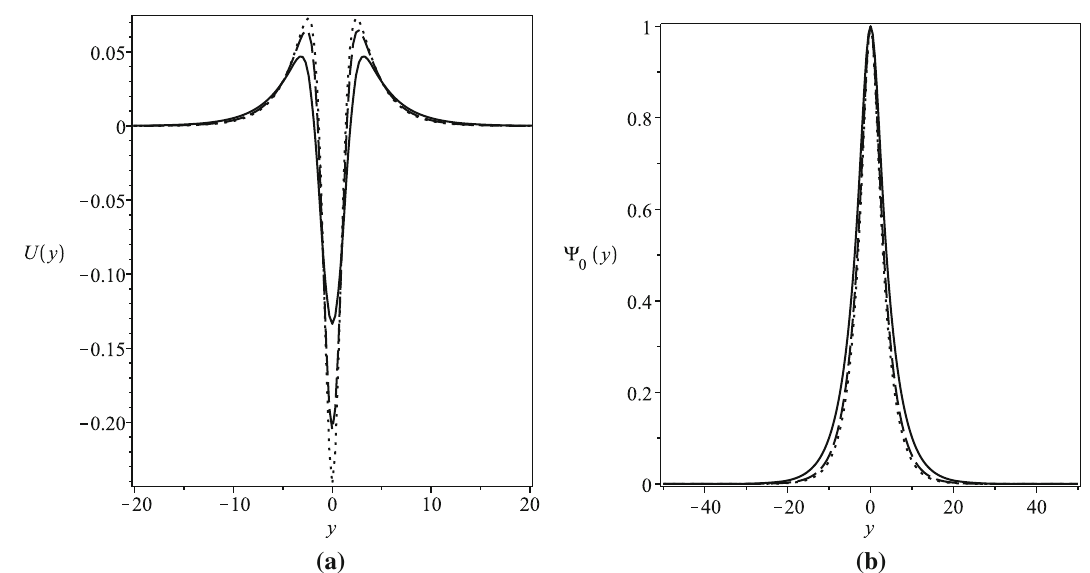
Fig. 3 The profile of a the potential U ( y ) and b the zero mode of graviton (cid:6) 0 ( y ) for a = 1(solid line), a = 2 (dashed line), a = 5 (dotted line)